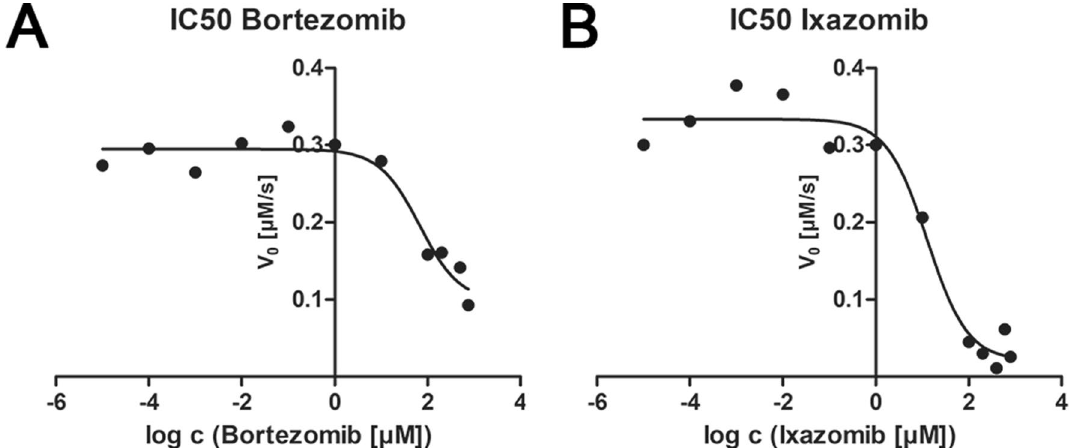
Figure 3. Inhibition assays showing the effect of Bortezomib ( A ) and Ixazomib ( B ) on β-lactam hydrolysis by CTX-M-14 β-lactamase. Initial rates of Cefotaxime hydrolysis are plotted against the log concentration of Bortezomib and Ixazomib, showing the decrease of hydrolysis rates at higher compound concentrations, resulting in calculated IC 50 values of 67 ± 1.4 µM for Bortezomib and 13 ± 1.2 µM for